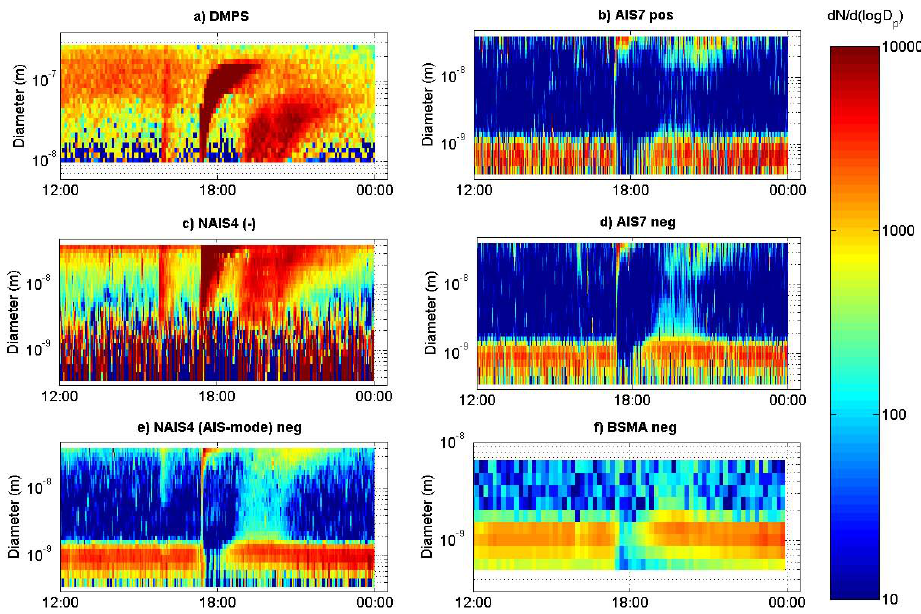
Fig. 8. Size distribution during the NPF event (12 June 2009) for a range of instruments. (a) DMPS, total concentration of aerosol particles, (b) AIS, positive air ions, (c) NAIS concentration of particles in particle operation mode (from the negative analyzer), (d) AIS negative air ions, (e) NAIS negative air ions, (f) BSMA negative air